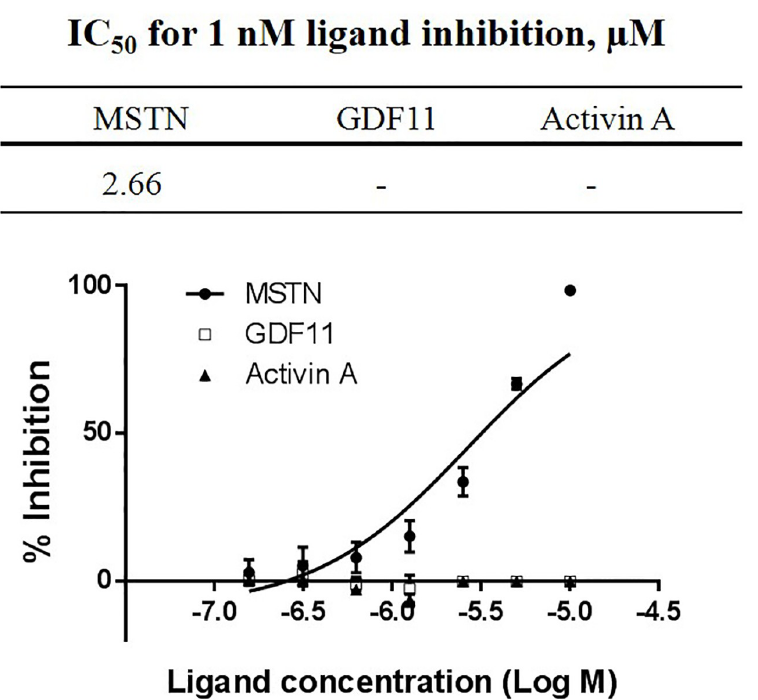
Fig 5. Inhibition of MSTN, Activin A, and GDF11 activities by Pep45-65-NH2. Various concentrations of Pep45- 65-NH2 (10, 5, 2.5, 1.25, 0.625, 0.313, and 0.156 μ M) in combination with 1 nM MSTN, GDF11 or Activin A were added to the HEK293 cells stably expressing (CAGA) 12 -luciferase gene construct, followed by incubation for 24 h. Luciferase activity was measured using Bright-Glo luciferase assay system (Promega, USA). The error bars indicate standard deviation (n = 3). Percentage of inhibition capacity = (luminescence at ligands (1 nM MSTN, GDF11, or Activin A)–luminescence at each MBP-Pro45-70-His6 concentration) × 100/(luminescence at ligands (1 nM MSTN, GDF11, or Activin A)–luminescence at 0 nM ligands. IC 50 (ligand concentration inhibiting 50% of MSTN) values were estimated by a non-linear regression model defining the dose-response